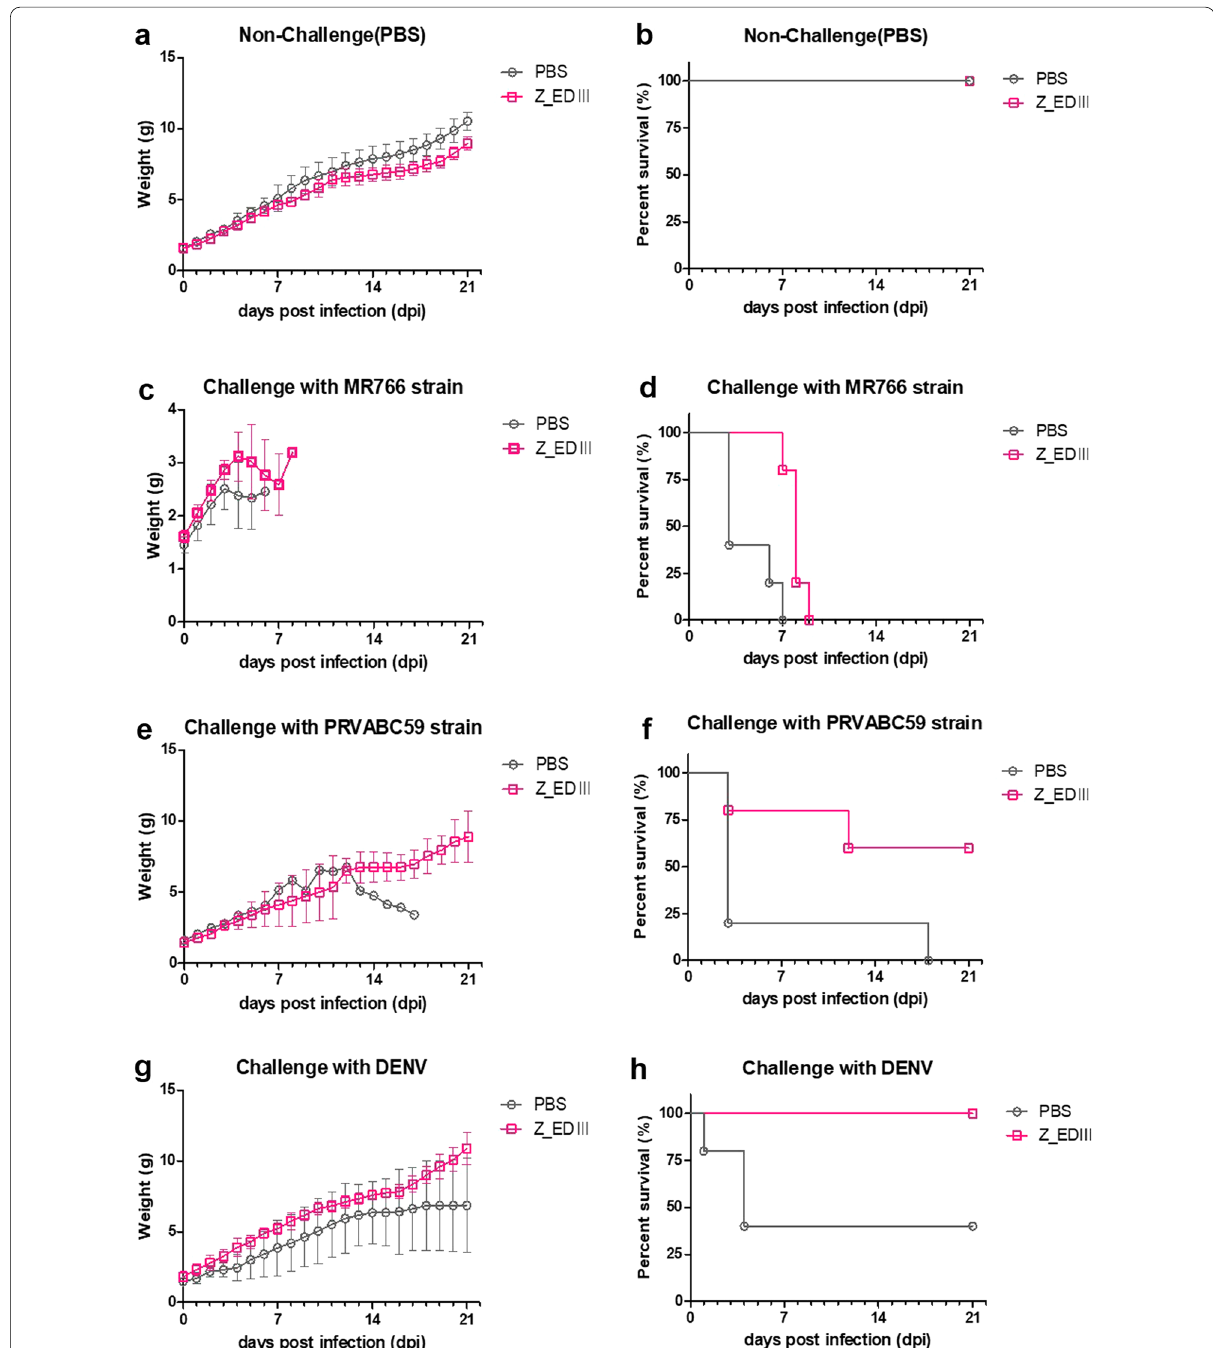
Fig. 7 Clinical results in neonates against ZIKV and DENV challenge. Body weight changes and survival rates were observed. C57BL/6 mice ( n per group) were immunized with Z_EDIII or PBS at 0, 14, and 42 dpi. Immunized females were mated with homozygous breeding pairs. The survival rate and body weight changes in neonatal mice ( n 5 per group) were observed. Two‑day‑old neonatal mice were inoculated with PBS ( a , b ), = MR766 ( c , d ), PRVABC59 ( e , f ), or DENV‑2 ( g , h ) strains. Data show the mean SD of five mice per group. Statistical analysis * p < 0.05, ** p < 0.01, ± *** p <